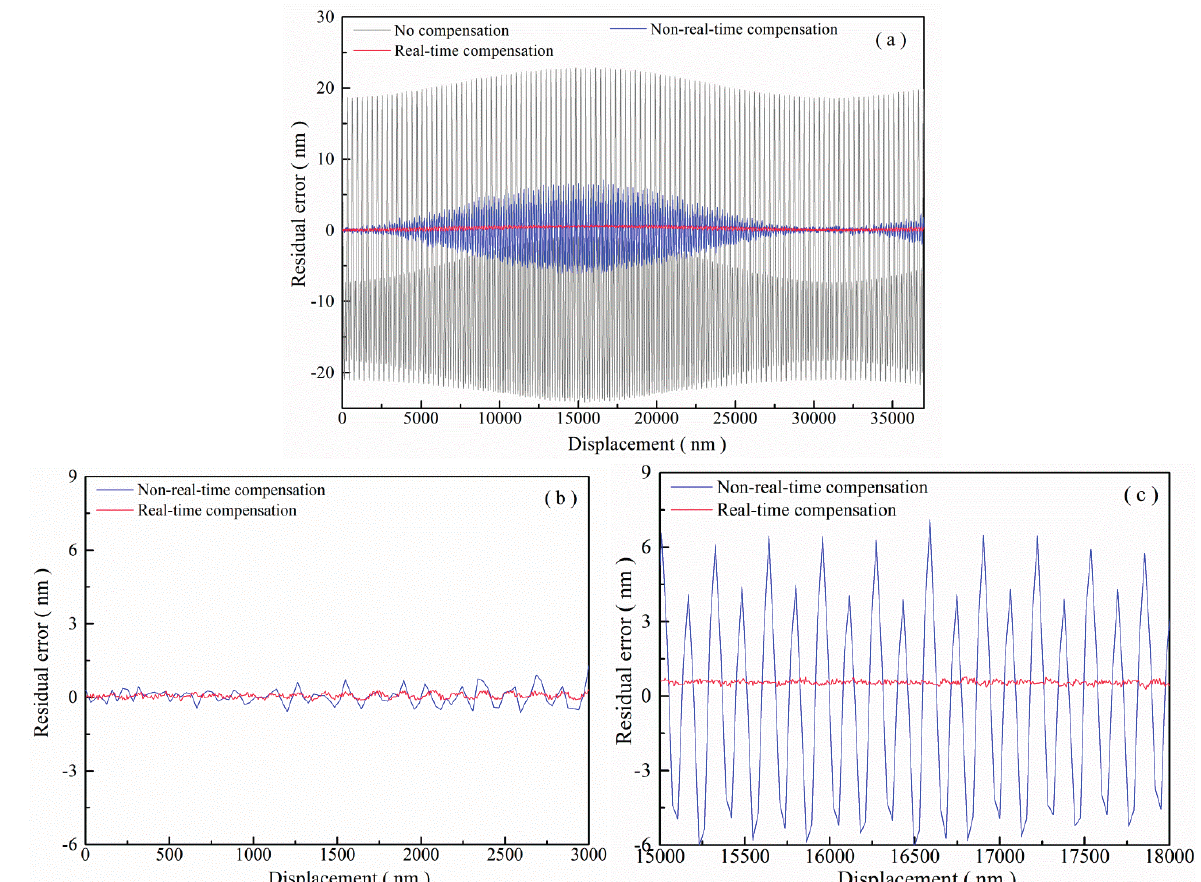
Figure 15. Experimental results of cyclic error compensation with simulated interference signals: ( a ) complete experimental results; ( b ) and ( c ) details of experimental